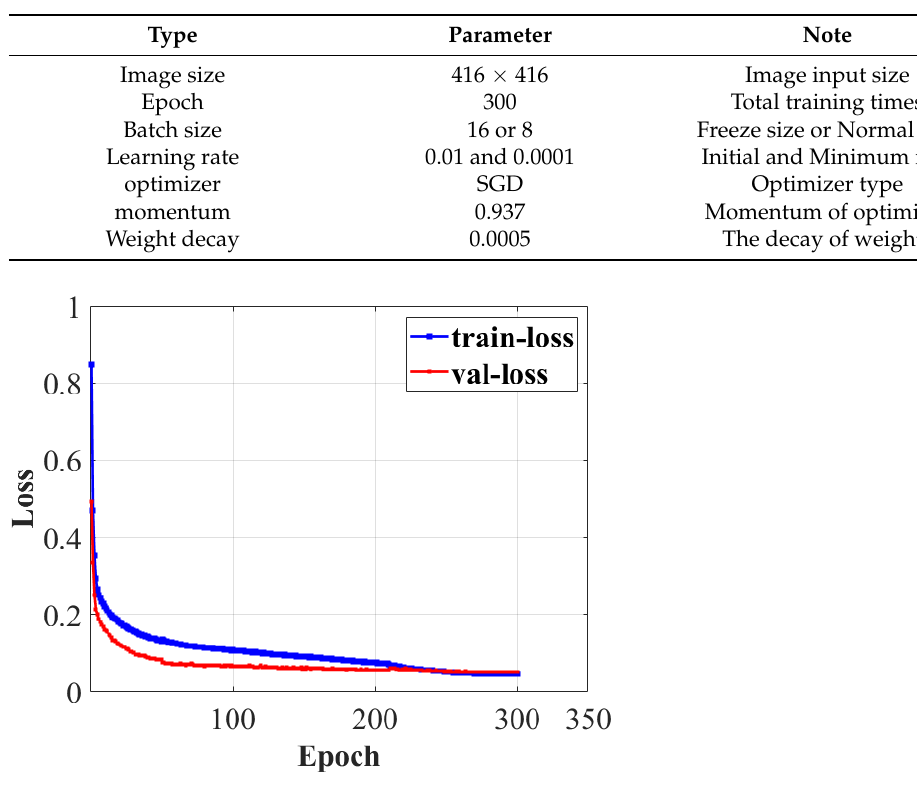
Table 3. The hyperparameter setting of model training.